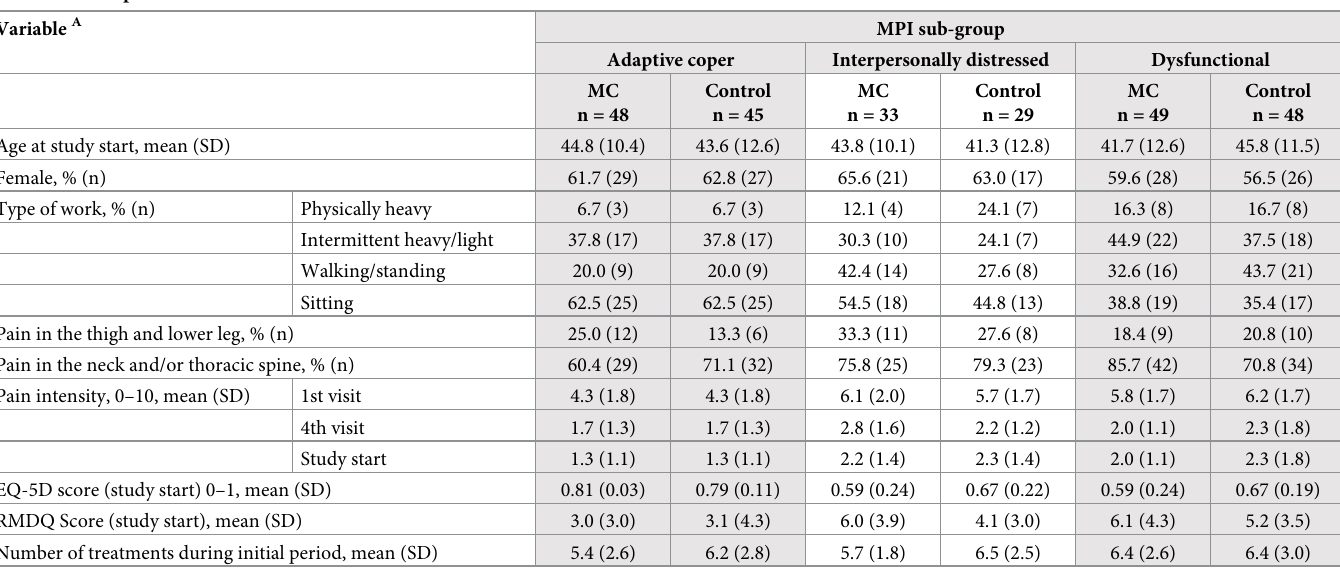
Table 1. Descriptive information.